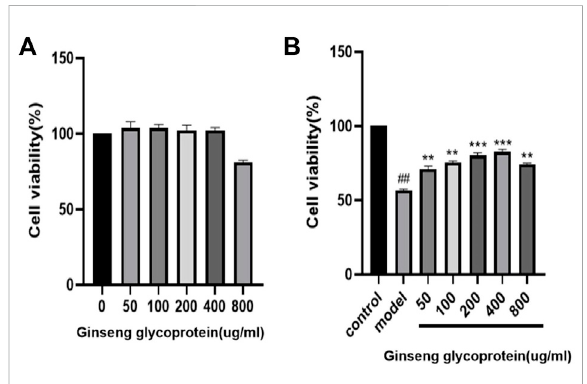
FIGURE 3 Ginseng glycoprotein has a pharmacological effect on the repair of UV irradiation. (A) Effect of ginseng glycoprotein on HaCaT cell viability; (B) Effect of ginseng glycoprotein on UV- induced HaCaT cell